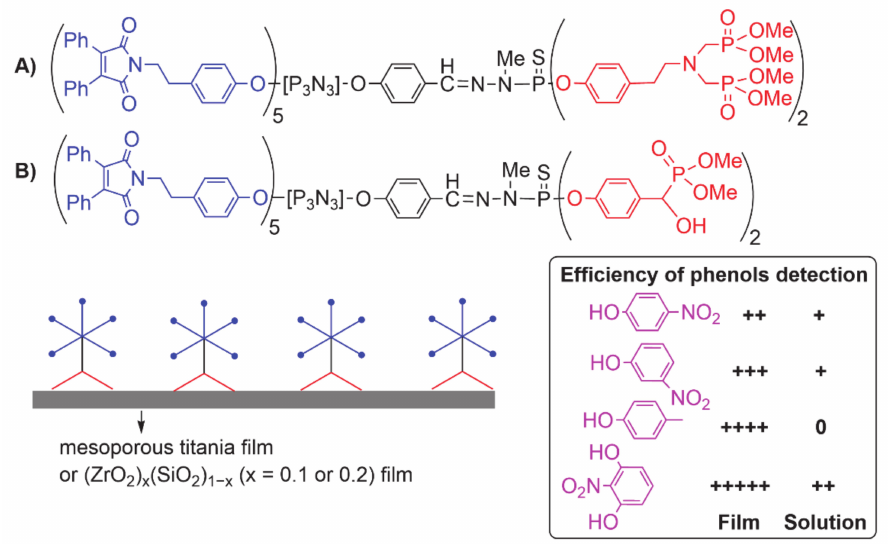
Figure 2. Dendrons grafted to solid surfaces. ( A ) Dendron grafted to mesoporous titania films. ( B ) Dendron grafted to (ZrO 2 ) x (SiO 2 ) 1 − x films surface. In the frame: efficiency of the dendron shown in ( A ) on titania or in solution for the detection of